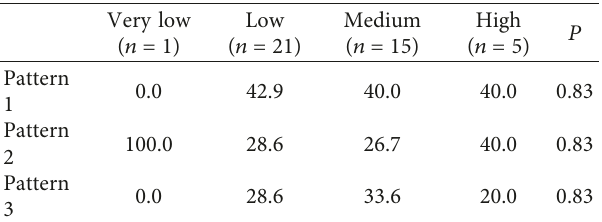
Table 6: Relationship of dietary patterns and the fitness level